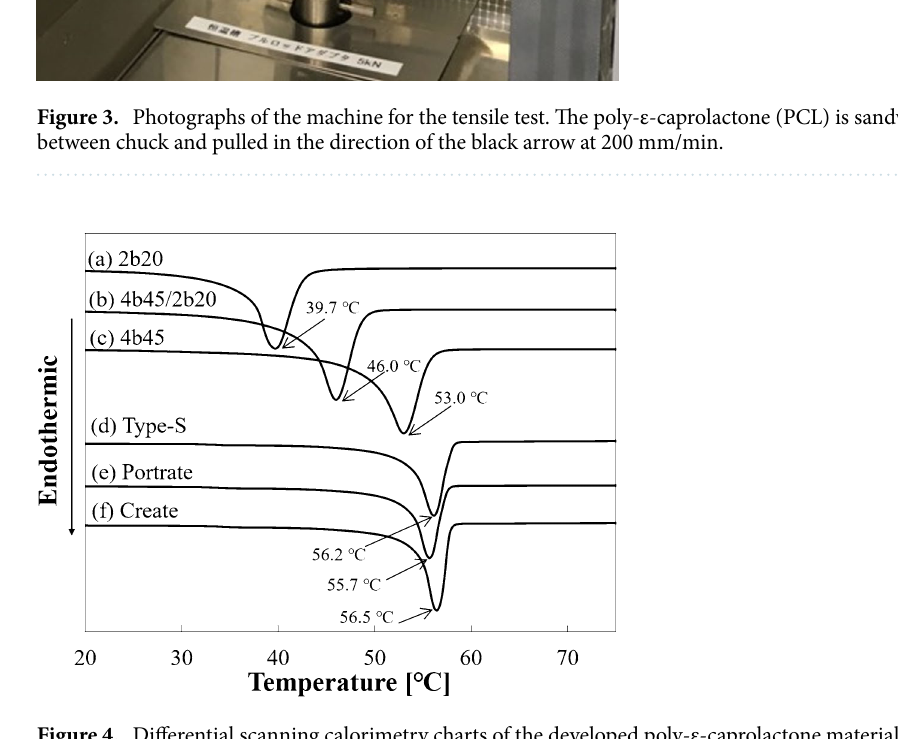
Figure 4. Differential scanning calorimetry charts of the developed poly-ε-caprolactone materials: (a) 2b20, (b) 4b45/2b20, and (c) 4b45, and commercially available masks: (d) Type-S, (e) Portrait, and (f) Create. The melting points measured from endothermic peak are